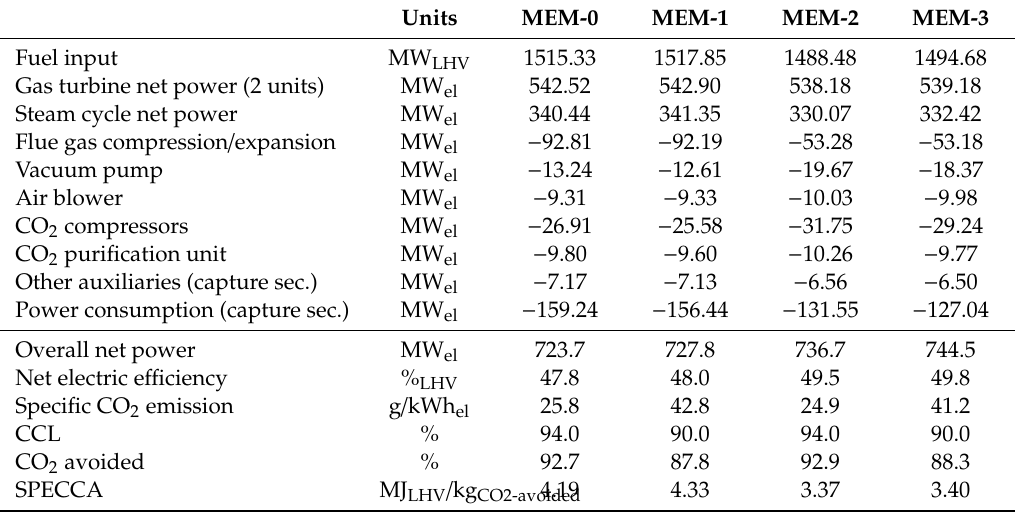
Table 9. Summary of thermodynamic performance for membrane-based